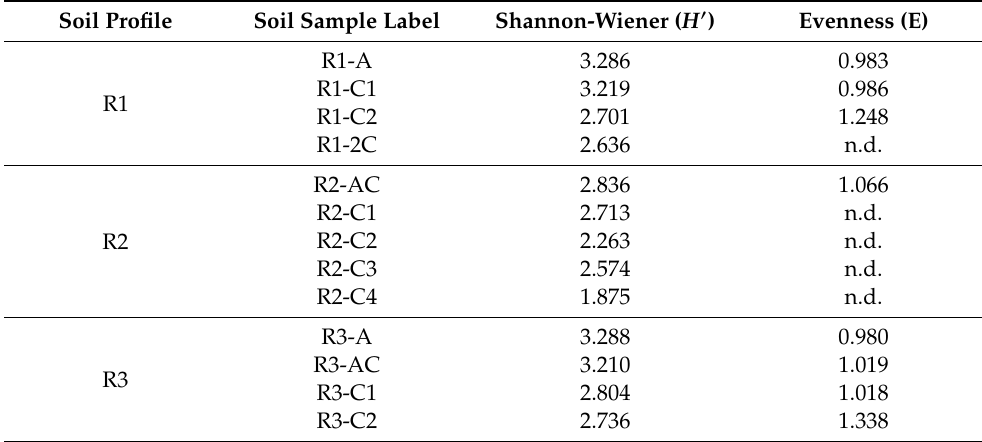
Table 3. Functional diversity indices evaluated by substrate utilization in the Biolog ® EcoPlates ™ calculated on data from all 31 carbon sources (n.d.—not